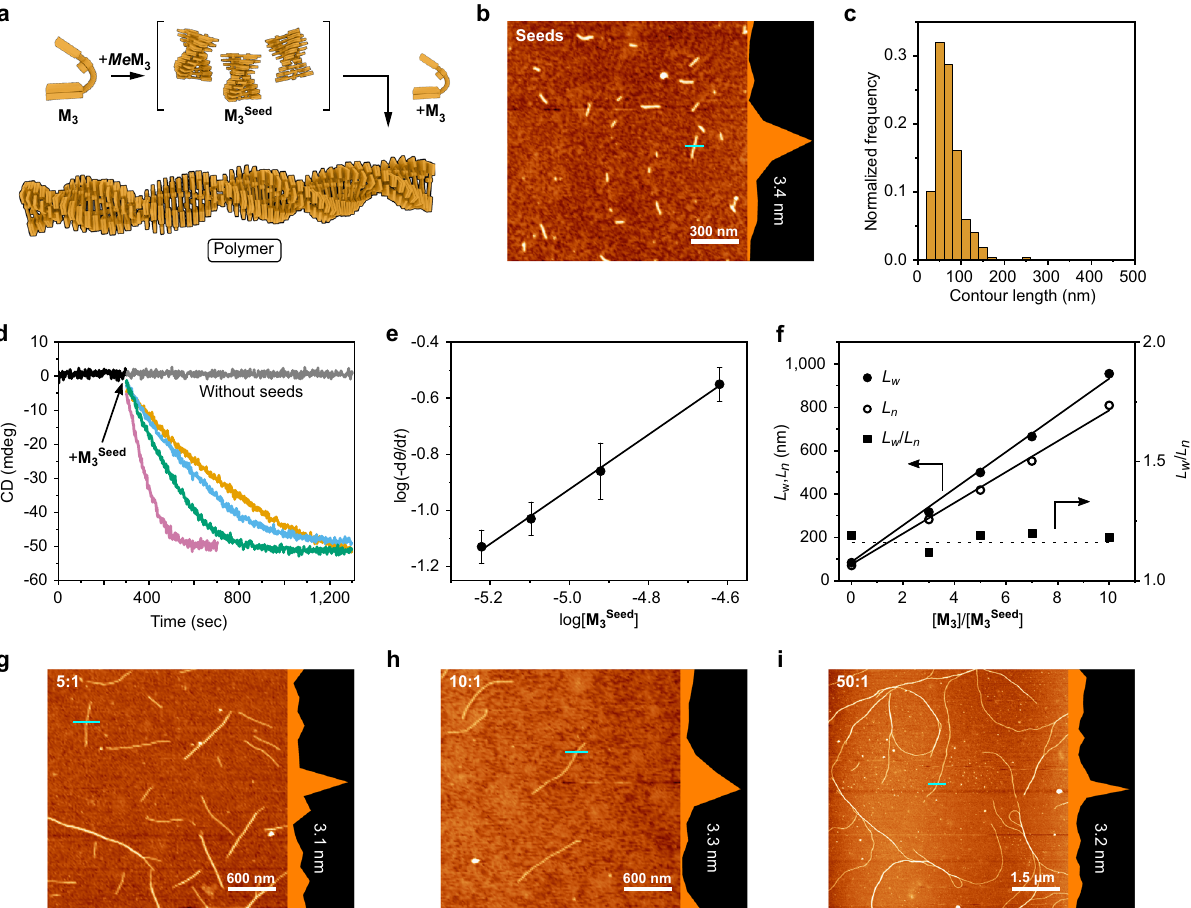
Fig. 4 Living supramolecular polymerization. a Schematic illustration of seeded living supramolecular polymerization. b AFM height image of M 3 Seed spin- coated on a silicon wafer. Cross-section was measured along the blue line. c Histogram of the length distribution of M 3 Seed . d Time course of supramolecular polymerization of M 3 initiated by addition of different amounts of M 3 Seed ([ M 3 ]/[ M 3 Seed ] = 50:1 (pink curve), 100:1 (green curve), 150:1 (blue curve), 200:1 (yellow curve) v/v). e Log-log plot of the rate of polymerization as a function of M 3 Seed concentration. Error bars correspond to one standard deviation of a triplicate measurement. Solid line – linear fi t with slope 0.97 (correlation coef fi cient 0.998). f Weight-average length ( L w ), number- average length ( L n ) and PDI ( L w / L n ) obtained by measuring AFM length of supramolecular polymers obtained with different [ M 3 ]/[ M 3 Seed ] ratios (3:1, 5:1, 7:1, 10:1 v/v) plotted against [ M 3 ]/[ M 3 Seed ] v/v. Solid lines represent linear fi t (correlation coef fi cients 0.995) indicating linear dependence of the size of supramolecular polymers on the amount of M 3 Seed added. Dashed line serves as guide for the eye. g – i Representative AFM height images of supramolecular polymers obtained with different [ M 3 ]/[ M 3 Seed ] ratios (( g ) 5:1, ( h ) 10:1, ( i ) 50:1 v/v) spin-coated on silicon